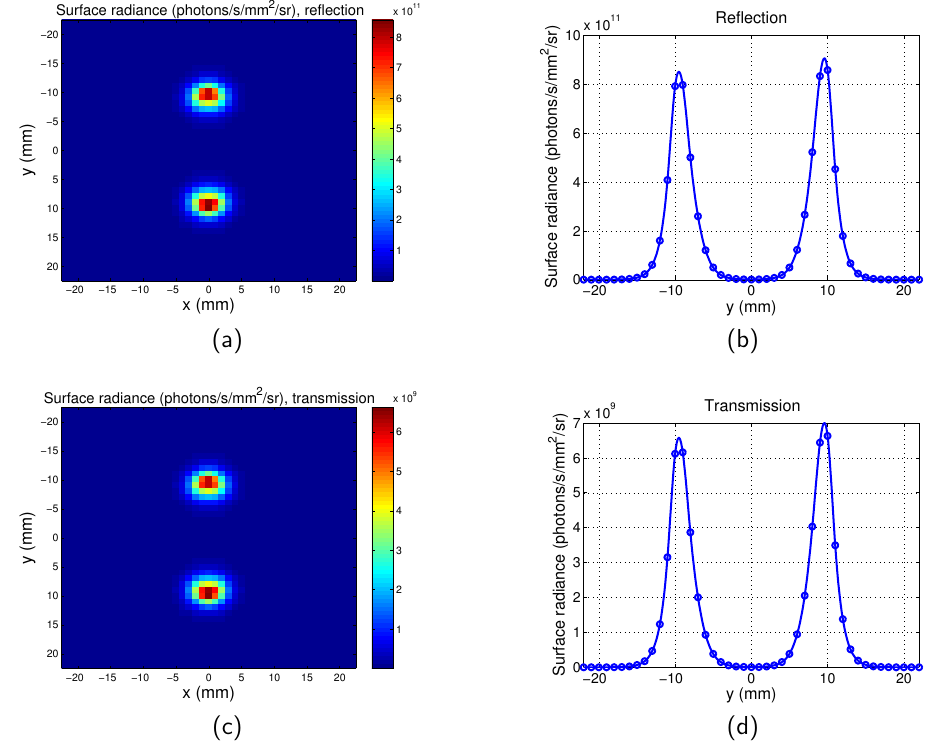
Figure 4. Surface radiance for scanning imaging system. z = − 4mm. Separation between the two targets is D = 16mm. λ ex = 600nm. λ em = 620nm. ( a ) Map for reflection mode; ( b ) surface radiance along y direction for x = 0mm for reflection mode; ( c ) map for transmission mode; and ( d ) surface radiance along y direction for x = 0mm for transmission